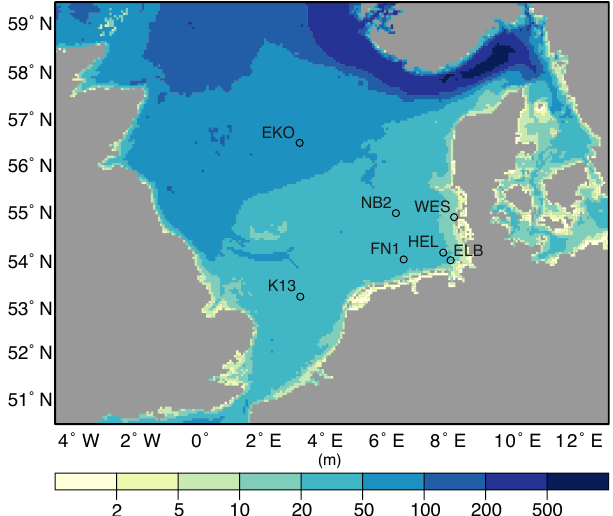
Figure 1. Model domain and bathymetry used for the fine-grid sim- ulation. Colours indicate water depth in metres. Circles mark obser- vational sites used for the model evaluation. For the abbreviations, see Table